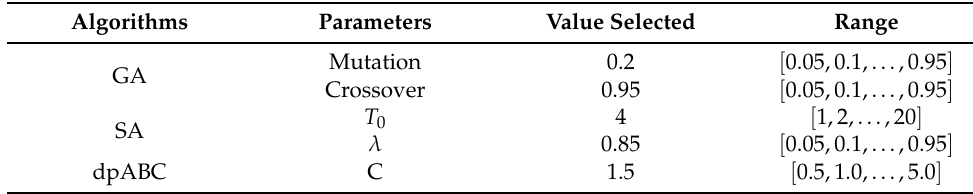
Table 1. Parameter selection of GA, SA, and dpABC.